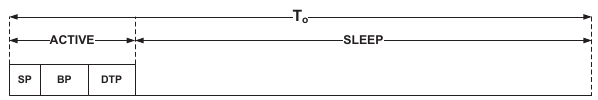
Figure 2. Synchronous scheduled